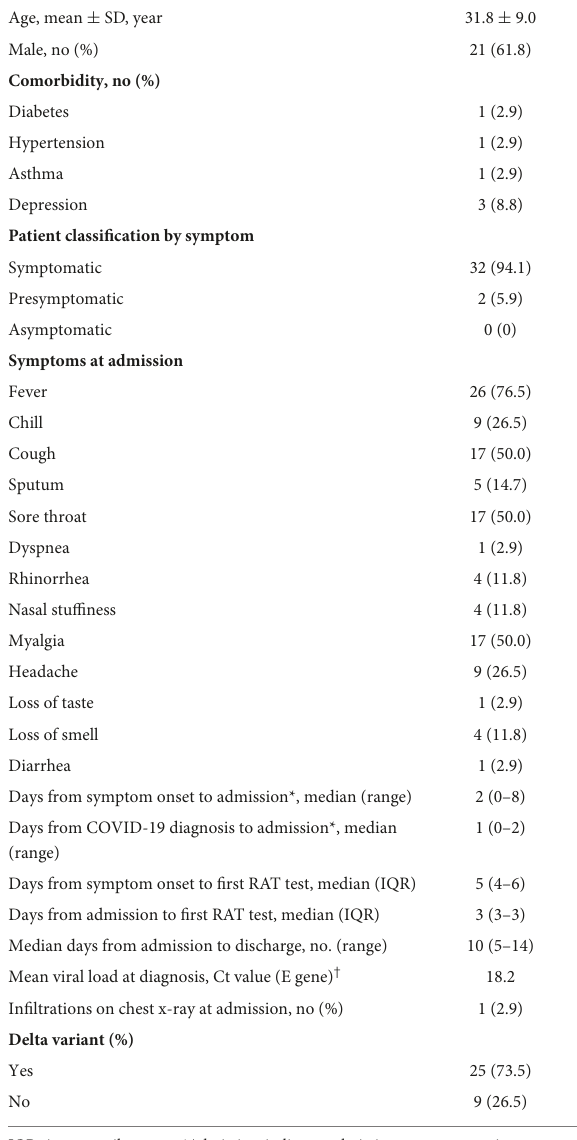
TABLE 1 Baseline characteristics of